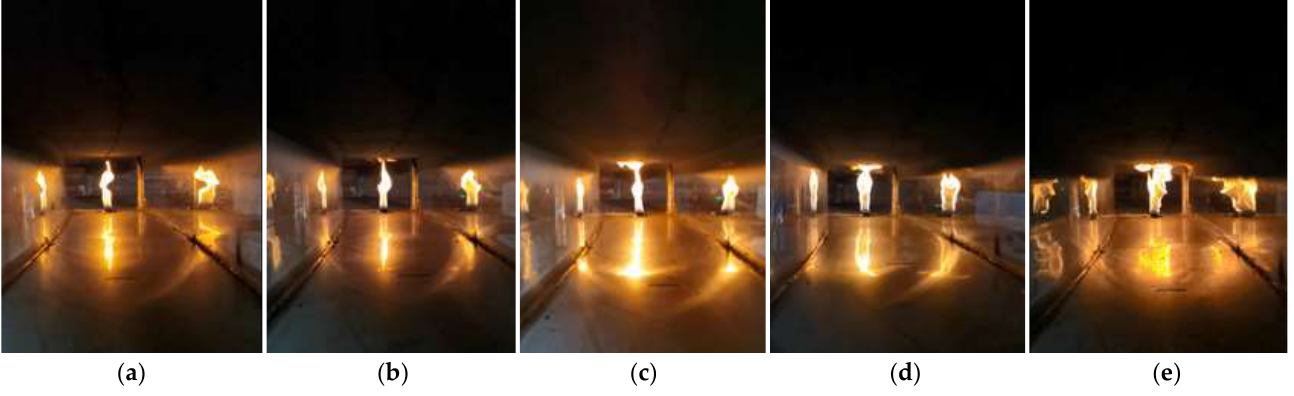
  . . = 0.76 kW; ( b ) Q = 1.01 kW; ( c ) Q = 0.76 kW; ( b ) Q = 1.01 kW;